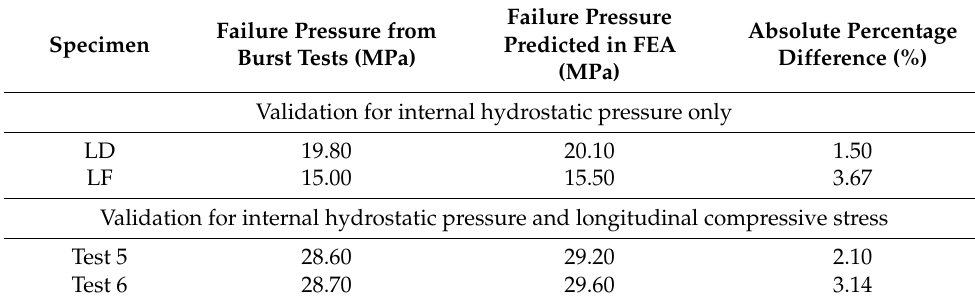
Table 3. Failure pressure from burst tests compared with failure pressure predicted in